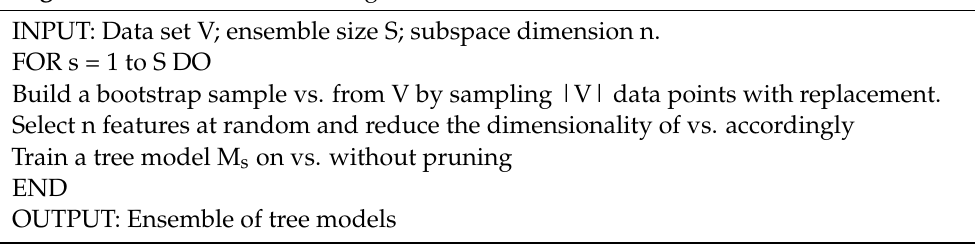
Algorithm 1: Random Forest Algorithm